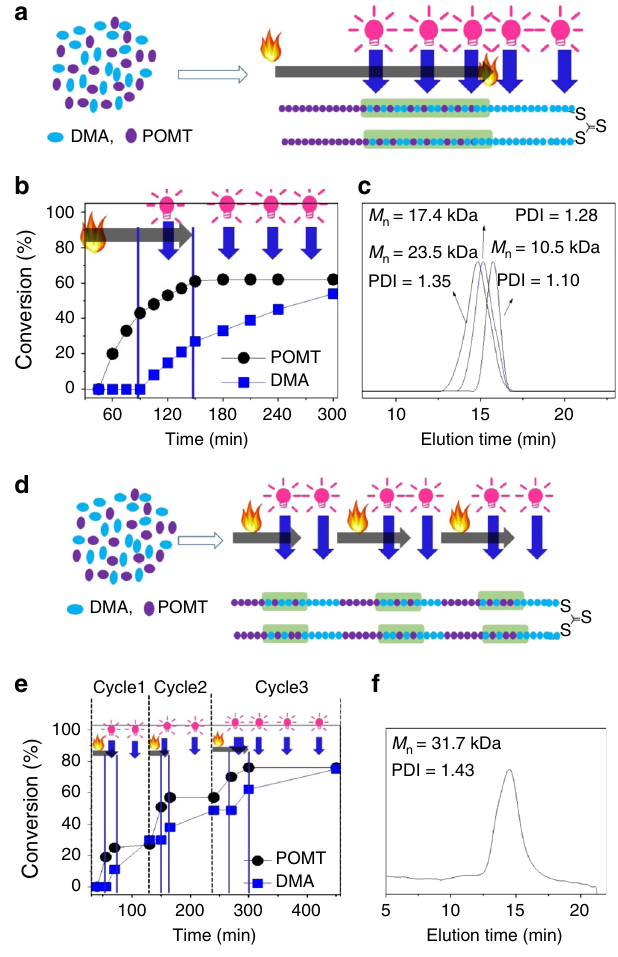
Fig. 7 Synthesis of copolymers with advanced sequence structures. a Scheme of synthesis of copolymers with controlled sequence structures via sequential heating, heating integrated with irradiation, and irradiation. b Monomer conversion vs. polymerization time under sequential heating, heating integrated with irradiation, and irradiation. c SEC traces of polymer irradiation. d Scheme of synthesis of copolymers with advanced